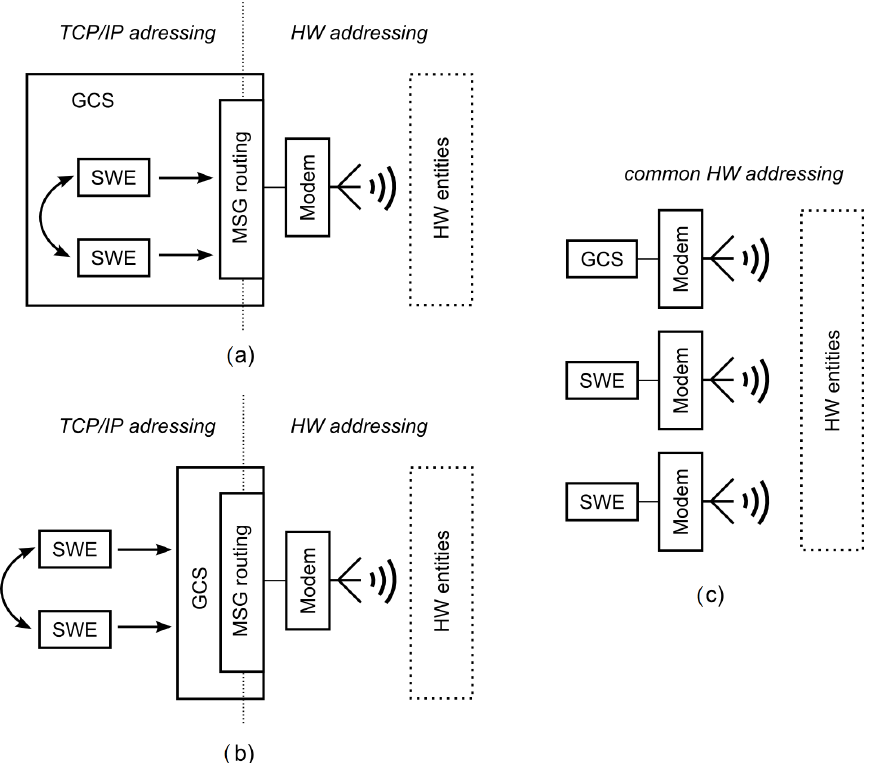
Figure 2. Various communication system architectures—( a ) virtual entities within a ground control station (GCS); ( b ) virtual entities apart from the GCS that use it for message relay; and ( c ) separated modems for all